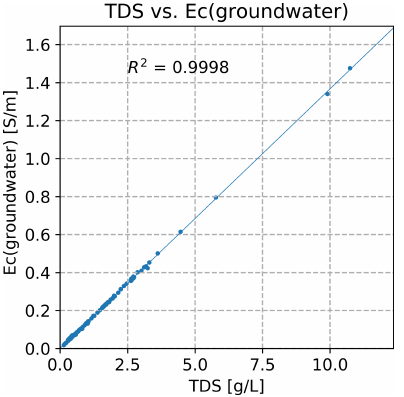
Figure B1. Linear relation between TDS and Ec(groundwater), based on data from Buschmann et al. (2008) and An et al.